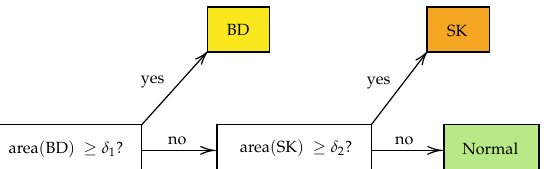
Figure 6. The pipeline for the classification of the tissue cuts is based on the combination of the results from single tiles. If the total area of BD in the tissue section exceeds a threshold δ 1 , the diagnosis BD is made. If the threshold δ 1 is not met, but the area of SK exceeds the threshold δ 2 , the diagnosis SK is set. Otherwise, the tissue is neither classified as BD nor SK.